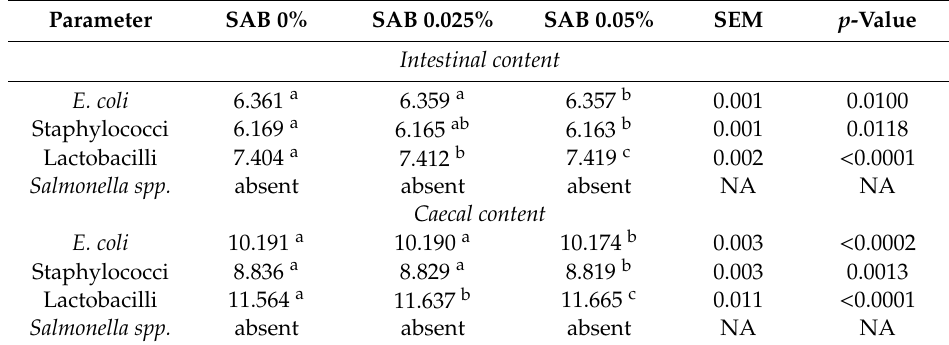
Table 5. E ff ects of dietary SAB powder on intestinal and caecal bacterial populations (lg10 CFU / g wet intestinal / caecal